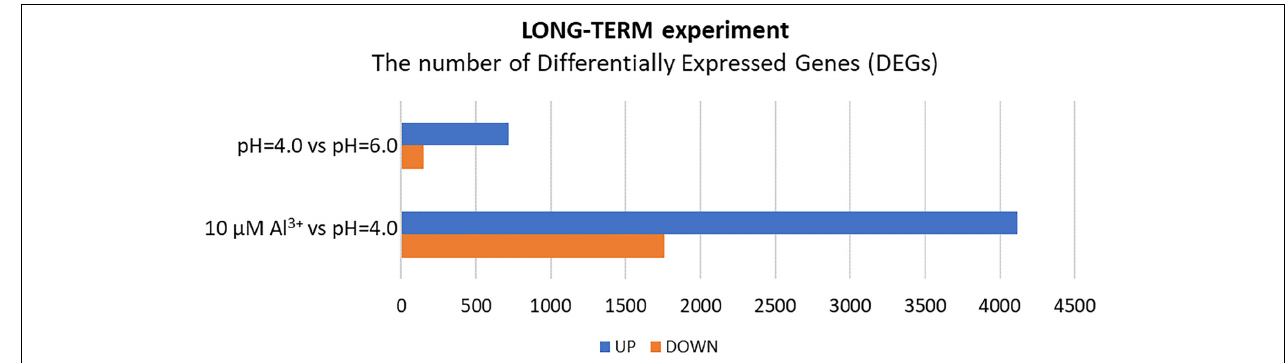
FIGURE 8 | The number of differentially expressed genes (DEGs) in the transcriptome of barley root meristems in the long-term experiment. DEGs were determined for plants grown at pH = 4.0 compared to pH = 6.0; and after treatment with 10 µ M Al at pH = 4.0 compared to pH = 4.0 without Al 3 + ions (DEGs were identified under α = 0.05 with FDR adjusted P -value and log 2 FC ≥ 1 or ≤ –1).